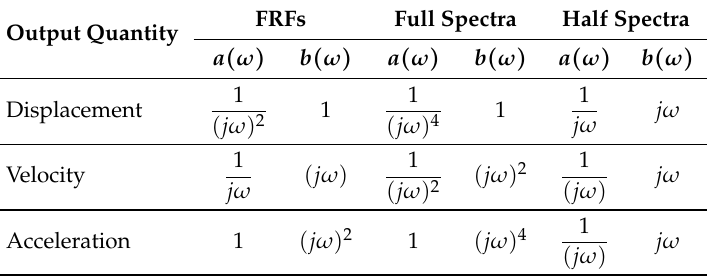
Table 1. Definition of the scalar functions, a ( ω ) and b ( ω ) , of the lower and upper residual matrices, LR and UR , according to the type of the measured output and to the analysis performed FRFs Full Output Quantity